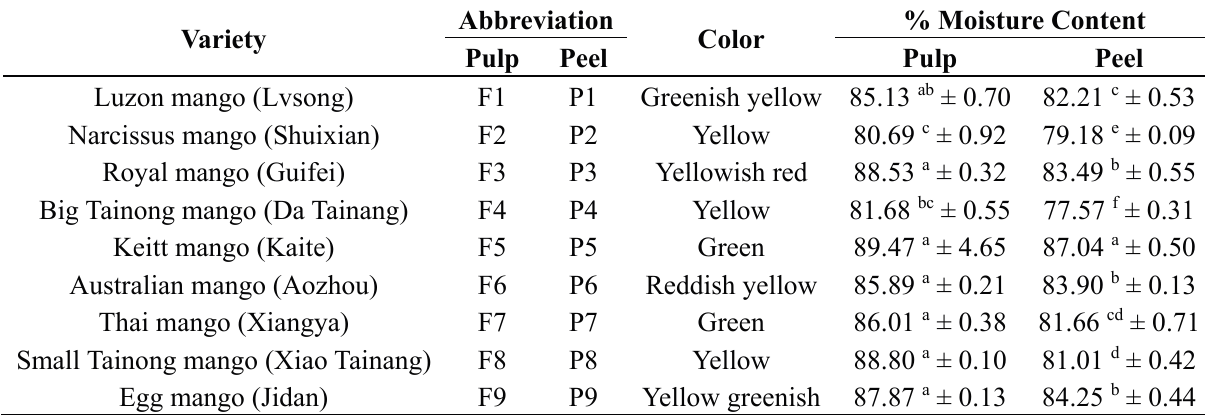
Table 1. Descriptions of the mango cultivars and the percentage of moisture